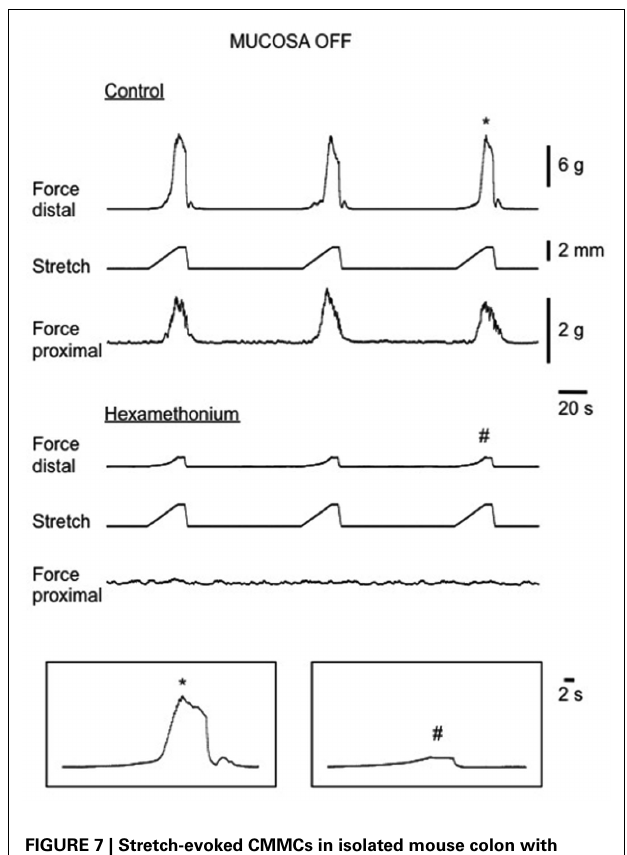
FIGURE 7 | Stretch-evoked CMMCs in isolated mouse colon with mucosa and submucosal plexus removed. Top traces show control CMMCs, evoked following each graded distension stimulus. Bottom traces show in the presence of hexamethonium stretch fails to evoke CMMCs in the proximal or distal colon. Passive increases in tension in the circular muscle layers are detected in the distal colon when each stretch stimulus is